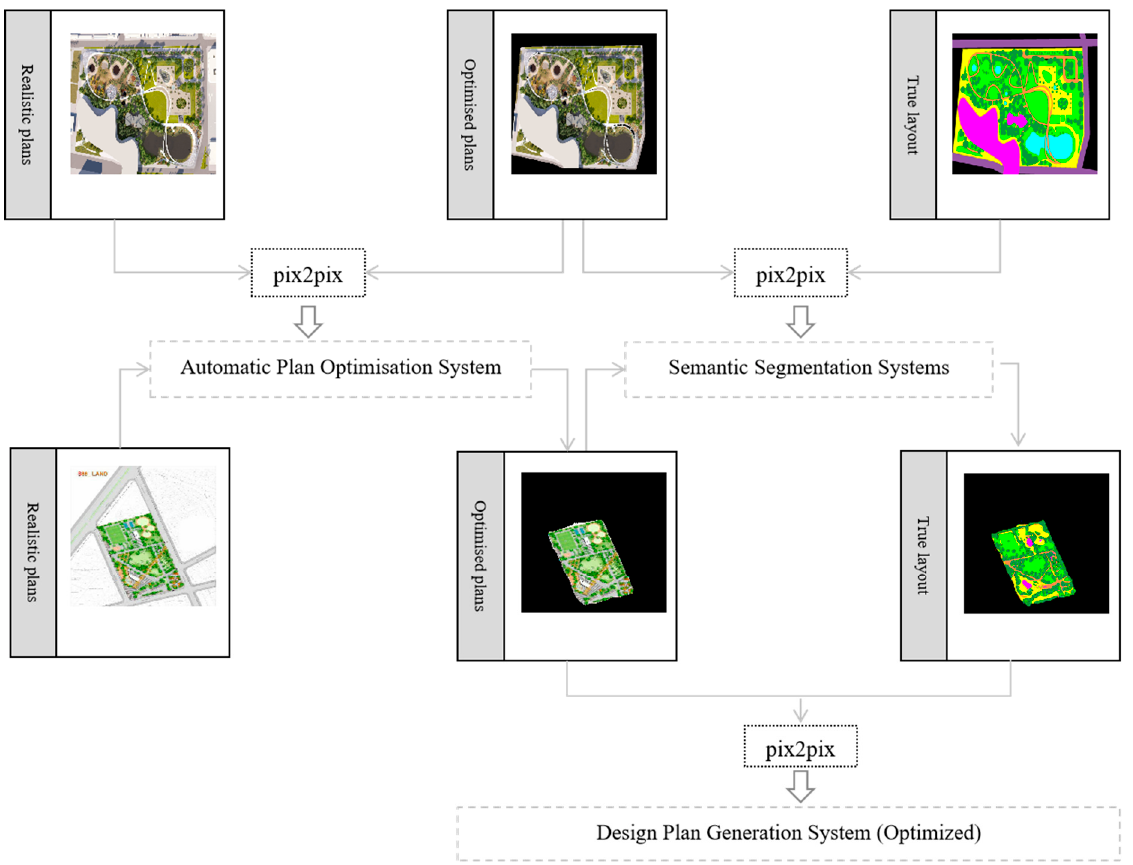
Figure 8. The optimization of design plan generation system.